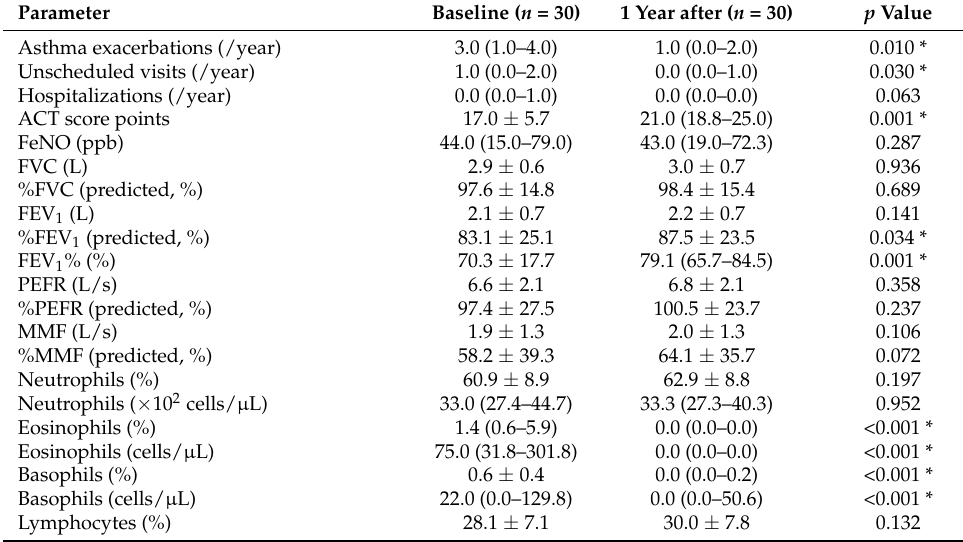
Table 3. Baseline characteristics of the study population and kinetics of parameters in patients treated with